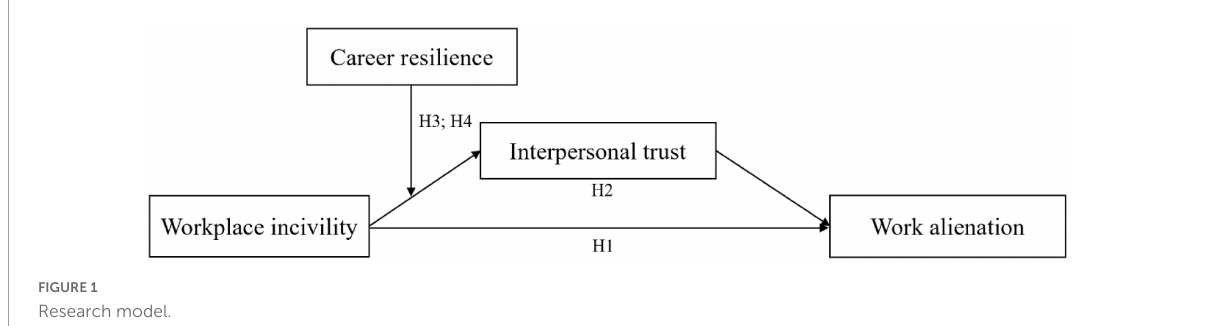
FIGURE1 Research